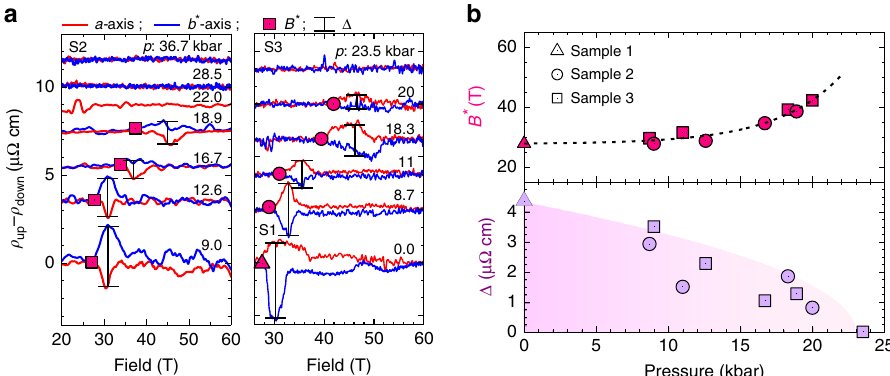
Fig. 3 Pressure evolution of the nematic state. a Difference between up- and down- fi eld sweeps (data from Figs. 1c and 2 and Supplementary Fig. 3) for I ∣∣ a (red) and I ∣∣ b * (blue), respectively. The onset fi eld B * is marked by squares. b (upper panel) Critical fi eld B * from all three samples. Dashed line is an exponential fi t. Lower panel: phenomenological strength of the nematic behavior, obtained as the maximal difference (marked in ( a ) by black bars) between each pair of curves.